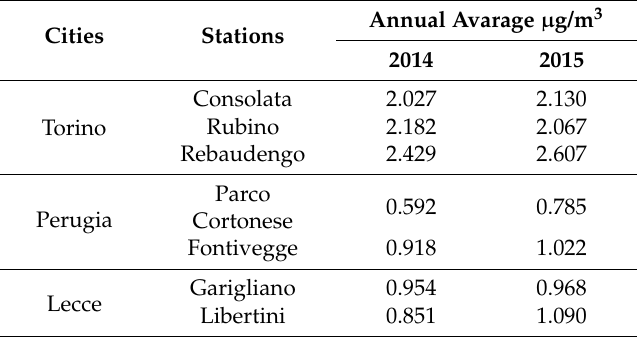
Table 3. Annual average of benzene registered by monitoring station in the cities involved in the